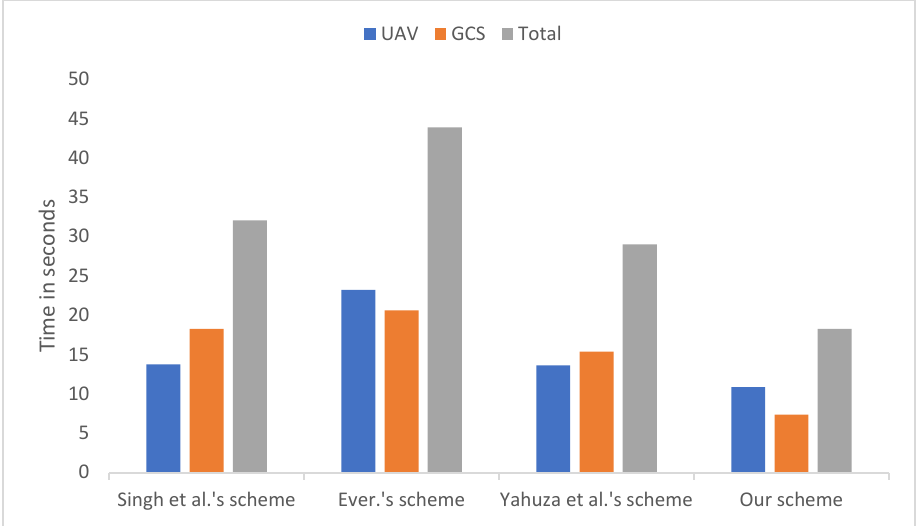
Figure 9. Comparison of costing by node.